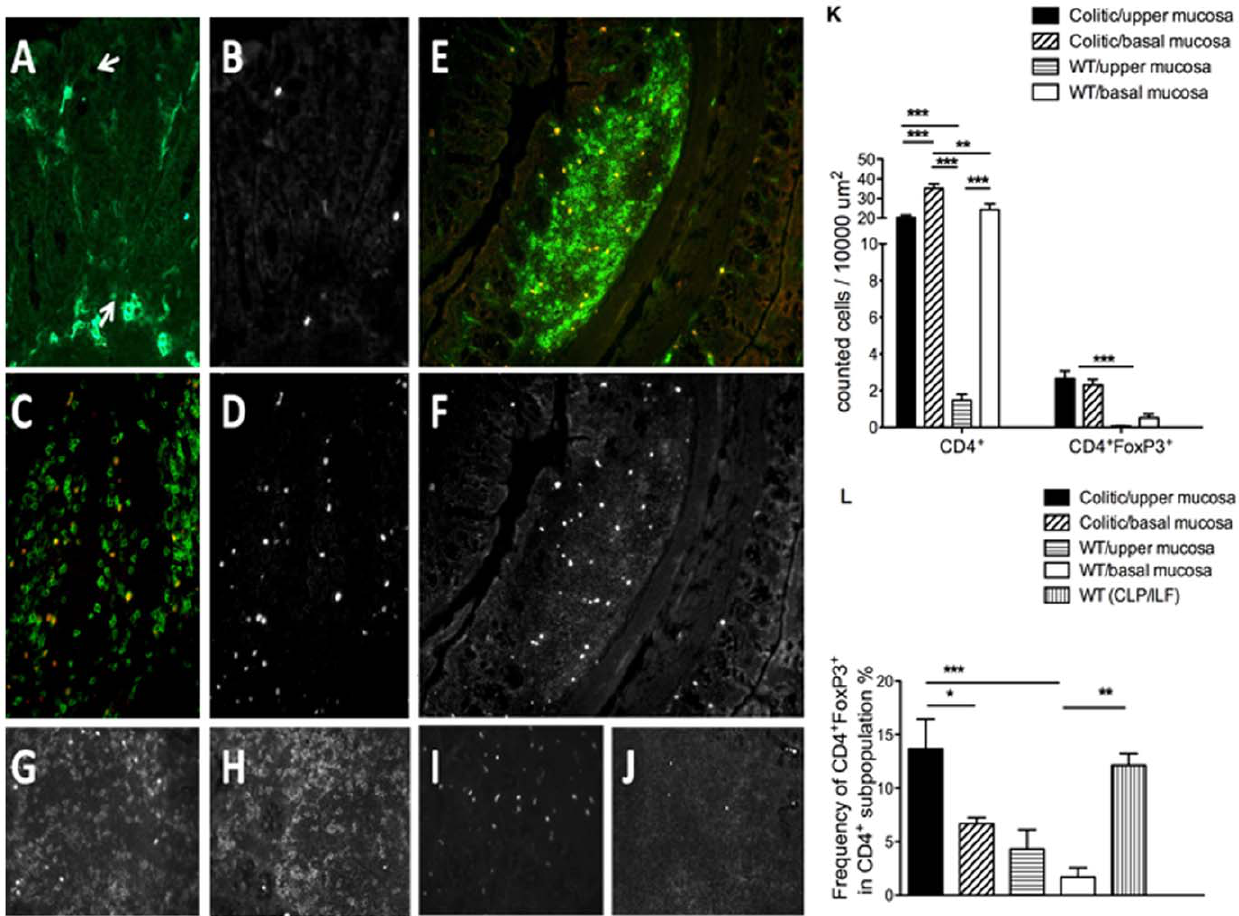
Figure 2. Immunohistochemical analysis of distribution of CD4 + FoxP3 + cells in colonic tissues. A, B, E, F=colon from WT mice; C, D=colon from G a i2 2 / 2 mice with colitis. Tissues were double stained for CD4 and FoxP3. Images shown are double positive (DP) CD4 + (green) FoxP3 + (red) (A, C, E) (where DP cells appear as yellow), or single positive (SP) FoxP3 (grey) (B, D, F); In WT colonic mucosa (A, B), CD4 + T cells were few in number and were mostly confined to the basal lamina propria. In colitis (C, D), CD4 + T cells infiltrated the entire lamina propria and included many DP cells. Within colonic lymphoid patches (CLP) of WT mice (E, F), interfollicular T cell areas contained many DP CD4 + FoxP3 + cells (compare to paucity of DP cells in normal mucosa to left and right). G–J, controls: G, CD4/FoxP3; H, CD4/FoxP3 isotype control; I, CD4 isotype control/FoxP3; J, CD4